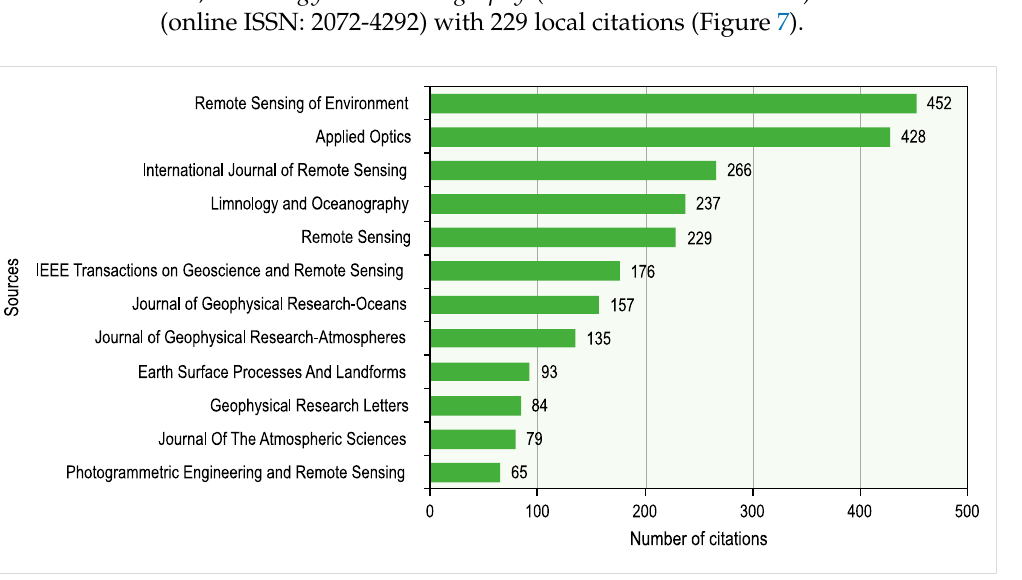
Figure 7. The number of citations from different sources accumulated from documents in the unified WoS and Scopus databases. Table 3. Top 16 journals for SDB (according to WoS).